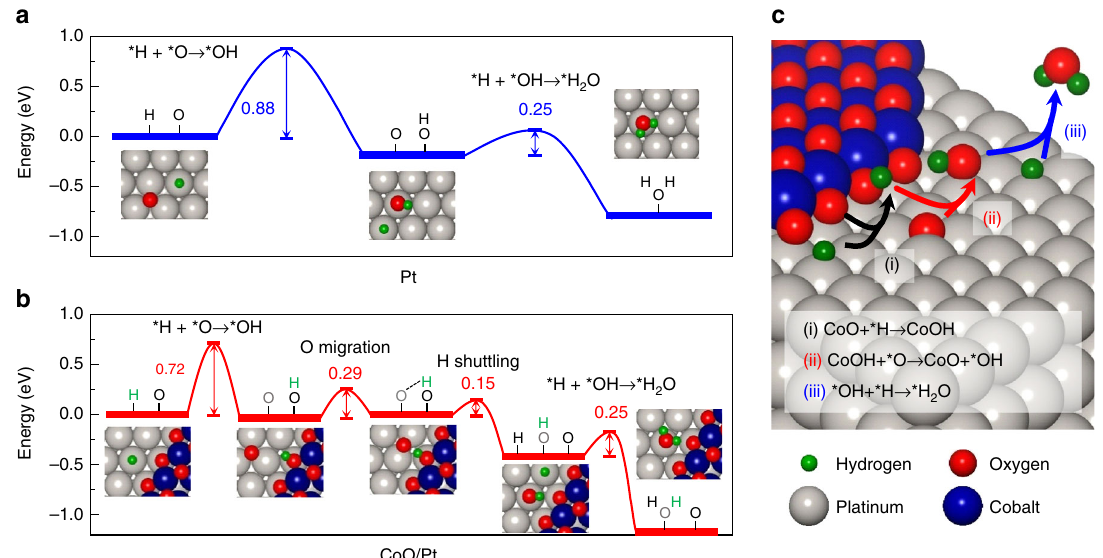
Fig. 5 Reaction pathways of H 2 oxidation calculated using DFT. Schematic energy diagram of the H 2 oxidation reaction a on the Pt (111) surface and b at the CoO/Pt interface. c Drawing showing the H 2 oxidation reaction mechanism at the periphery of the CoO/Pt